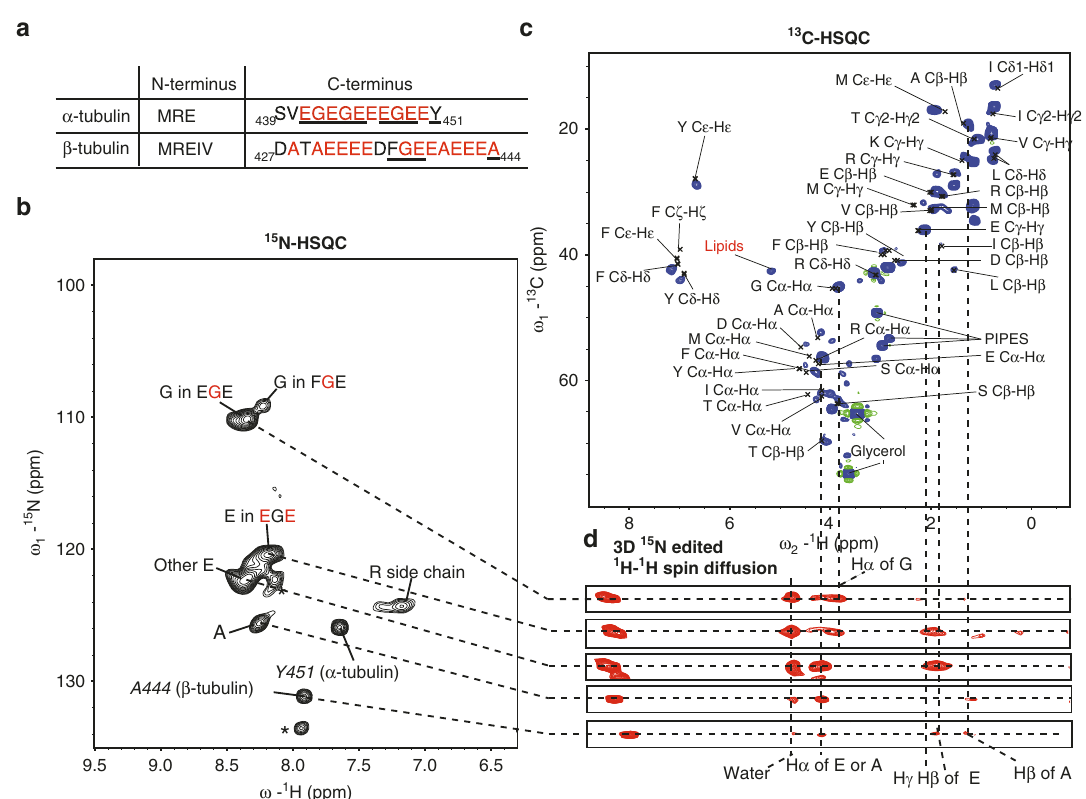
Fig. 3 Flexible tubulin C-terminal investigated by J-based ssNMR. a The sequences of N- and C-termini of tubulin. Underlined residues showed sequential correlations in our ssNMR data sets. The protein sequences of α 1 and β 1 tubulin isotypes were used for analysis based on previous results 26 . b 2D 15 N-HSQC of [ 13 C, 15 N]-labeled MTs showed the fl exible tubulin tails. c 2D 13 C-HSQC of [ 13 C, 15 N]-labeled MTs showing the residues present in the tubulin tails. Due to the high fl exibility, the signals from side chains of leucine, lysine as well as buffer compounds and lipids were also observed. d Strips